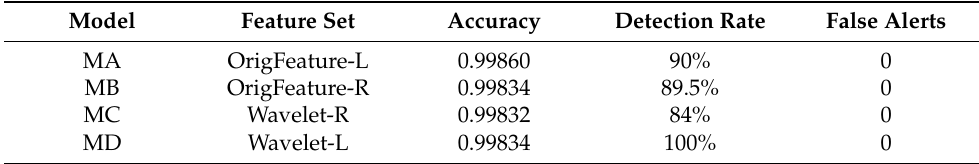
Table 1. Performance of the developed